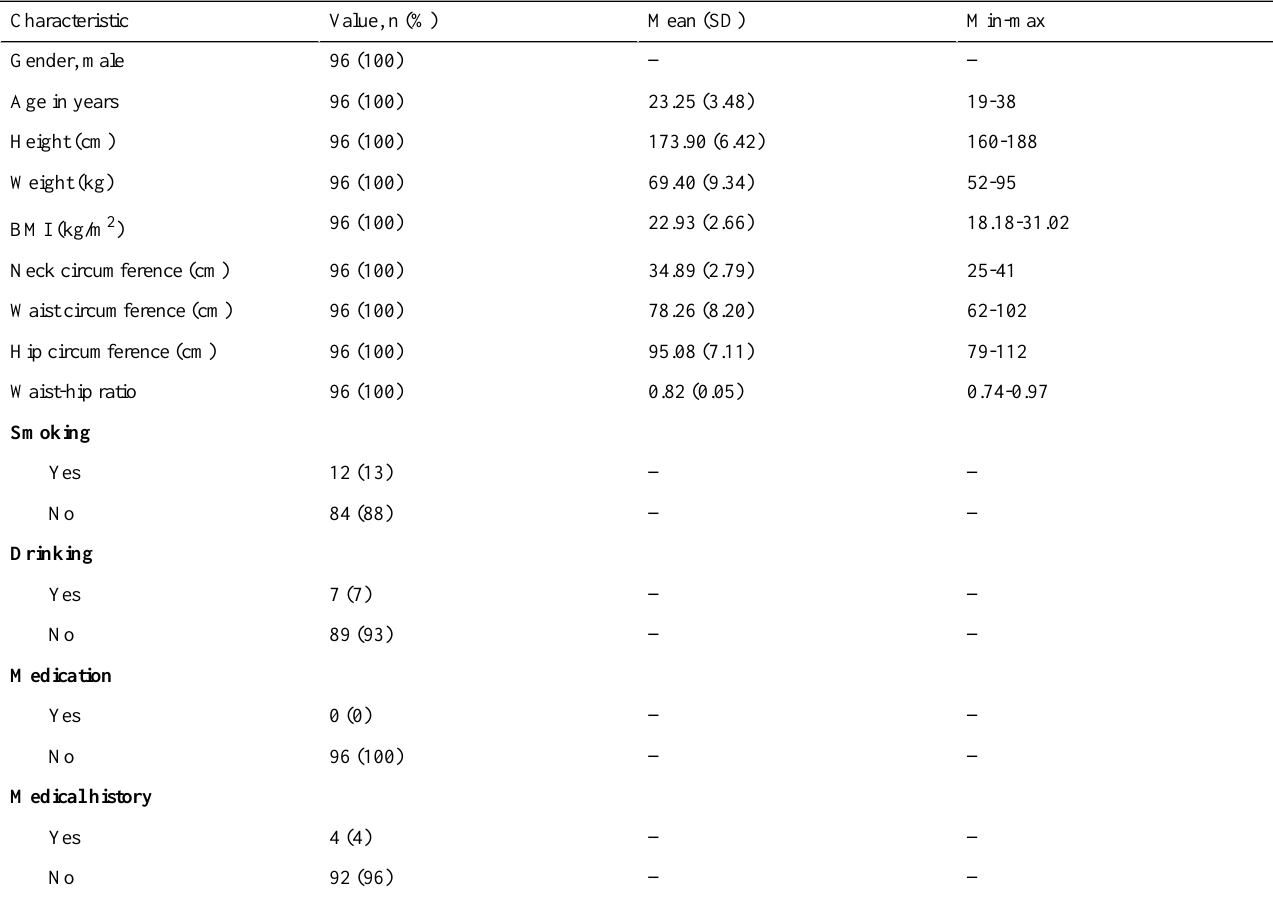
Table 1. Descriptive demographic characteristics of participants